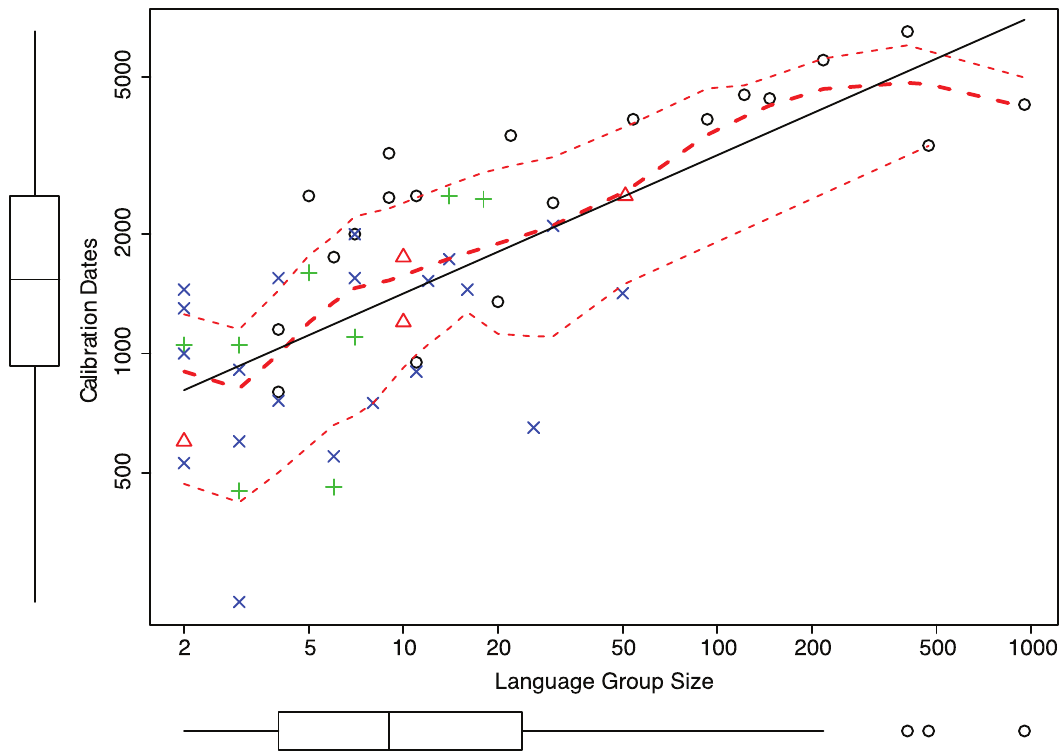
Figure 1. Calibration dates against the number of languages in a language group. 0 s are archaeological, D s are archaeological and historical, z s are epigraphic and | s are historical dates.